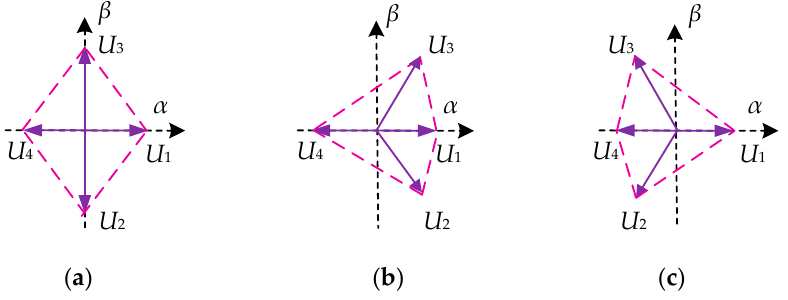
Figure 3. Voltage vectors of the fault-tolerant BVSC with phase a leg fault. ( a ) U dc 1 = U dc 2 ; ( b ) U dc 1 < U dc 2 ; ( c ) U dc 1 > U dc 2 .